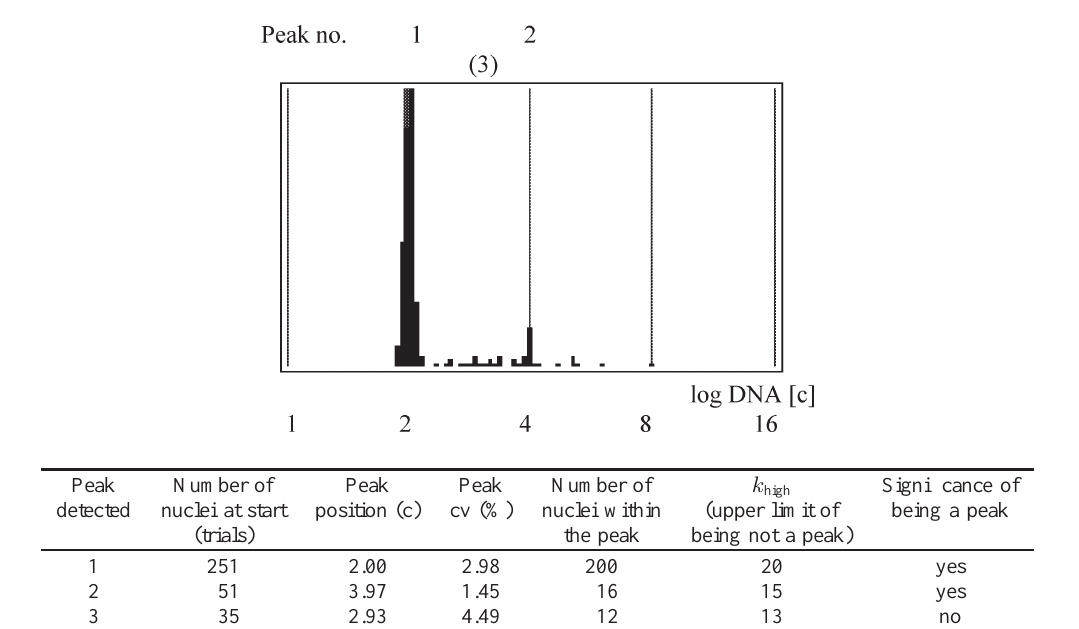
Fig. 4. DNA histogram of a breast cancer with obviously two “spikes”. Both are defined statistically as peaks. The details of the statistical figures are given below the histogram.